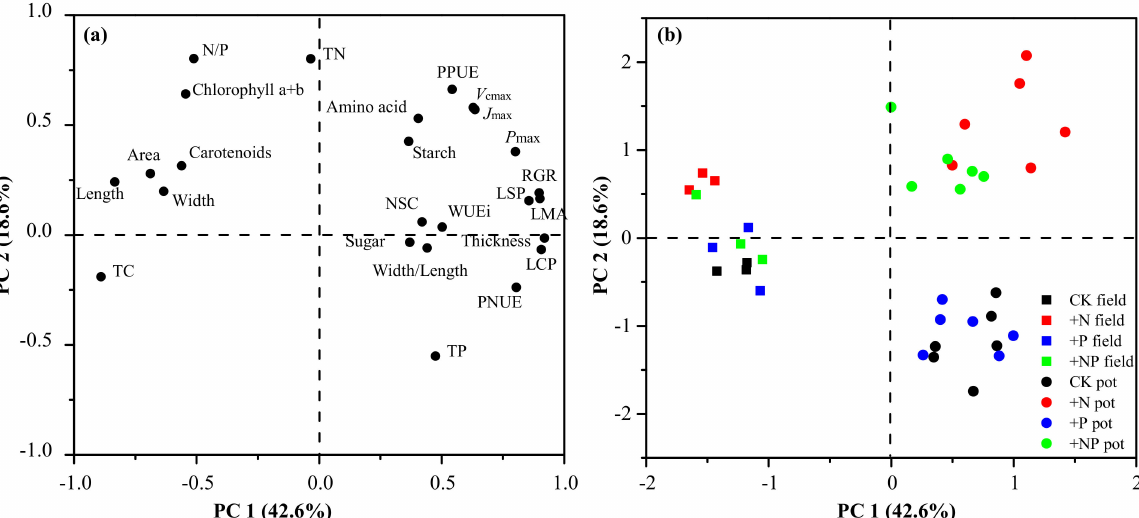
Figure 6. Principal component analysis for ( a ) 24 leaf traits and relative growth rates (RGR) and ( b ) Schima superba under field and pot experimental nitrogen and phosphorus addition for the first two axes. Black, red, blue, green indicate CK, +N, +P and +NP treatment under pot (circles) and filed (squares) conditions, respectively. Leaf traits are shown in Figures